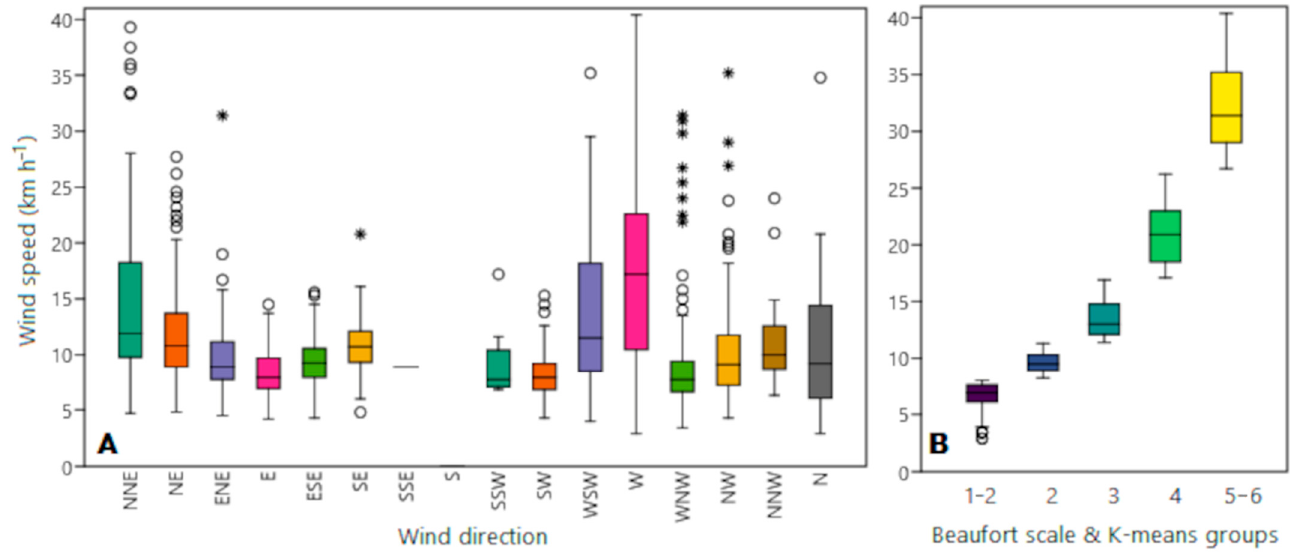
Figure 3. ( A ) Average daily wind speed (km h − 1 ) in each of the wind rose sectors. The circles and asterisk indicate the outlier values. ( B ) Grouping of values according to K-means and equivalence with the Beaufort scale.